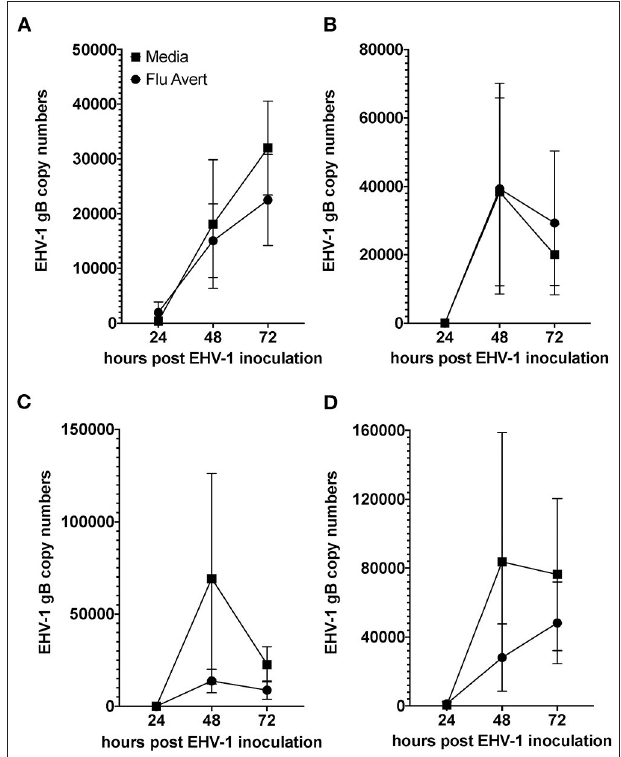
FIGURE 3 | Mean ± SEM difference in extracellular EHV-1 copy number between Flu Avert-treated and media-treated ERECs from five horses. (A) Extracellular copy number in cells treated with Flu Avert or media on day 1 prior to EHV-1 inoculation. (B) Extracellular copy number in cells treated with Flu Avert or media on day 2 prior to EHV-1 inoculation. (C) Extracellular copy number in cells treated with Flu Avert or media on day 5 prior to EHV-1 inoculation. (D) Extracellular copy number in cells treated with Flu Avert or media on day 7 prior to EHV-1